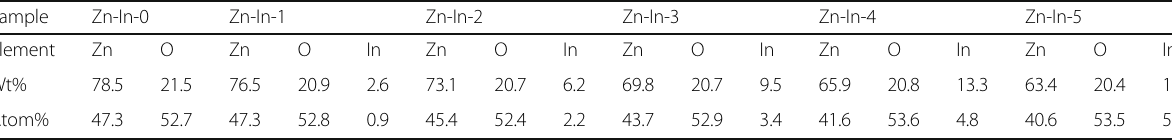
Table 1 Weights and atomic percentages of elements in ZnO/In 2 O 3 composites